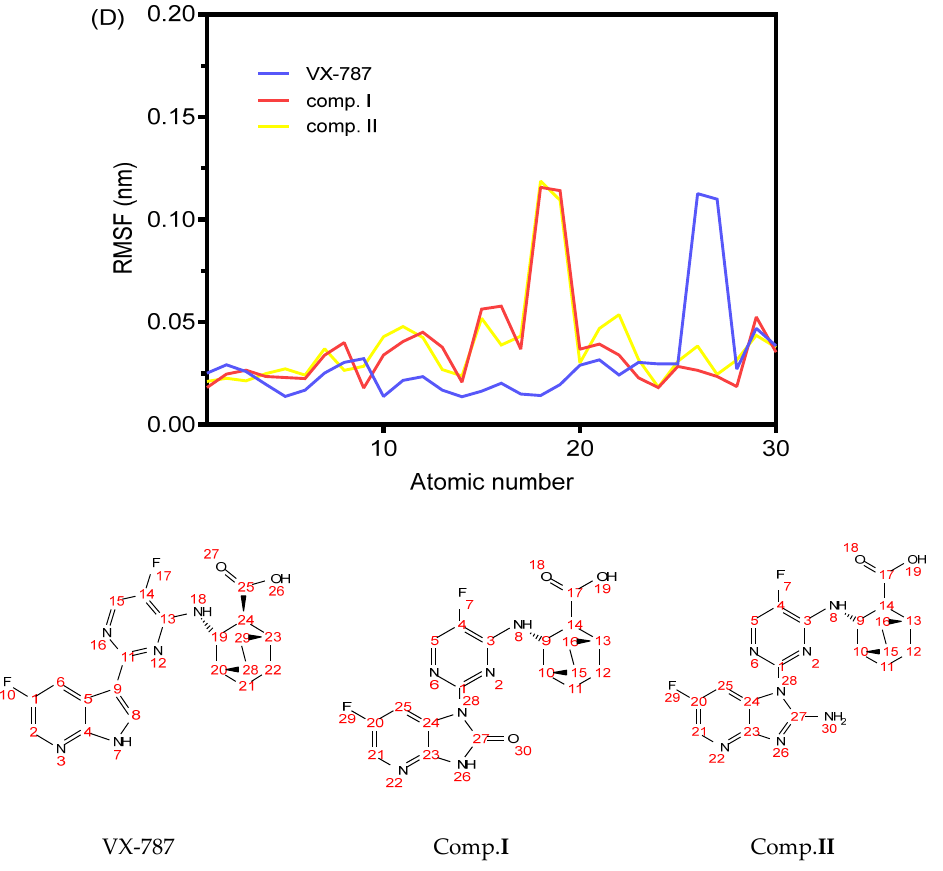
Figure 7. Stabilities of VX-787, comp. I , and comp. II in PB2 protein during 100 ns molecular dynamics (MD) simulations. ( A ) RMSD values of PB2 protein backbone of the PB2/ligand complexes. ( B ) RMSD of Lig fit Prot values for VX-787, comp. I and comp. II . ( C ) RMSF values of amino acids of PB2/ligand complexes. ( D ) The RMSF values of atomic positions of VX-787, Comp. I and Comp. II .